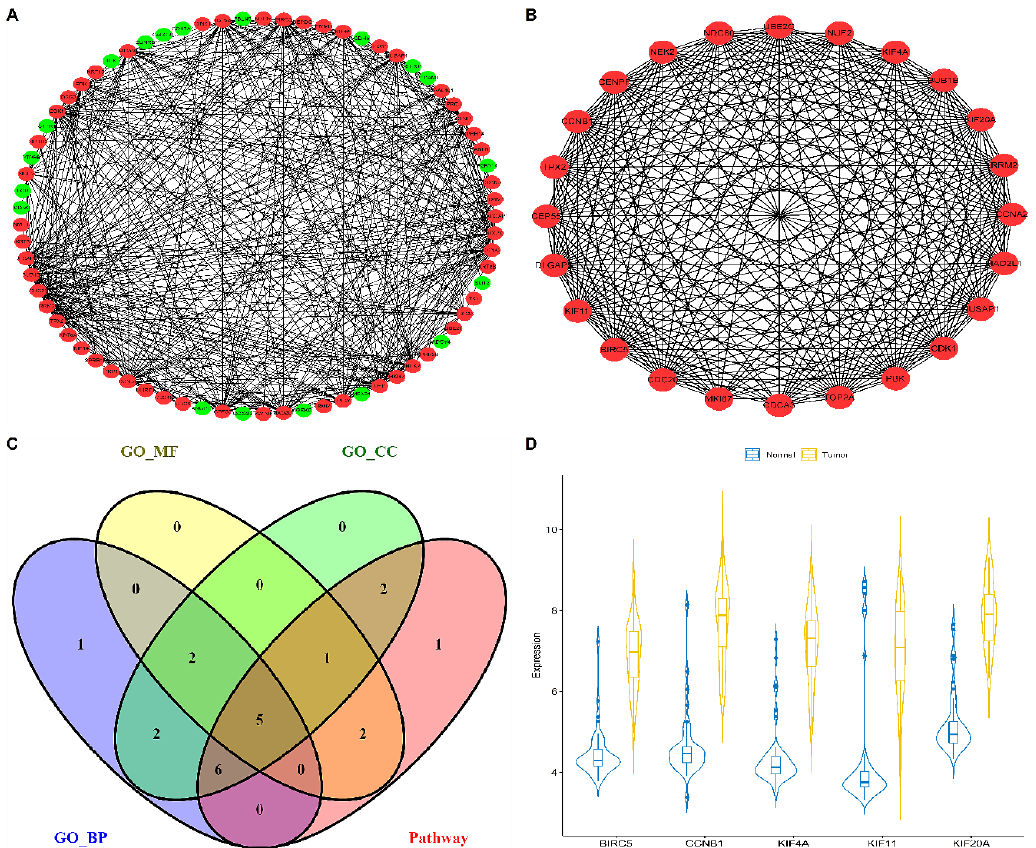
Figure 3. ( A ) Protein–protein interaction (PPI) network comprising 73 nodes and 433 edges constructed using the STRING database. The red and green colored nodes represent up and downregulated proteins. ( B ) Top scoring PPI cluster consists of 24 nodes and 256 edges. (C) Overlapping hub genes (BIRC5, CCNB1, KIF4A, KIF11, and KIF20A) between significantly enriched GO terms (BP, MF, and CC) and pathways represented as a Venn plot. ( D ) Violin plots showing the expression distribution density of the 5 hub genes across normal and tumor samples. The top and bottom of the embedded box inside the violin represent the 75th and 25th percentile of the distribution, respectively. The thick black line inside each box represents the median values. Normal and tumor samples are distinguished by blue and yellow colors, respectively. Genes are shown at the bottom and the endpoints of the axis are labelled by the minimum and maximum values.